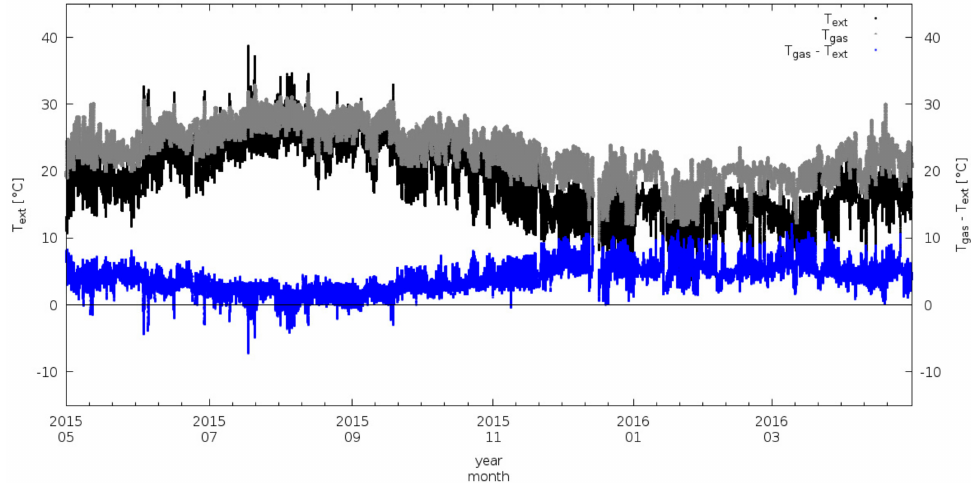
Figure 10. Time series of ambient air temperature ( T ext , black), internal temperature of gas intake ( T gas , grey) and their differences ( T gas - T ext , blue). 1-min average values are reported.